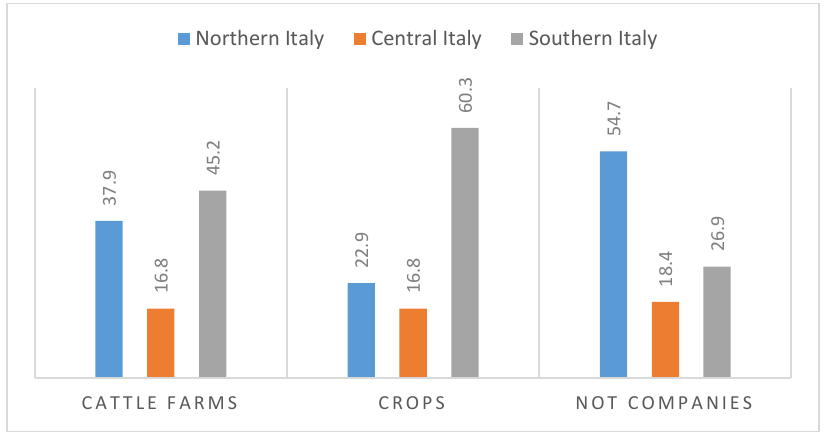
Figure 1. Distribution of farms in Italy, percentage values [1].